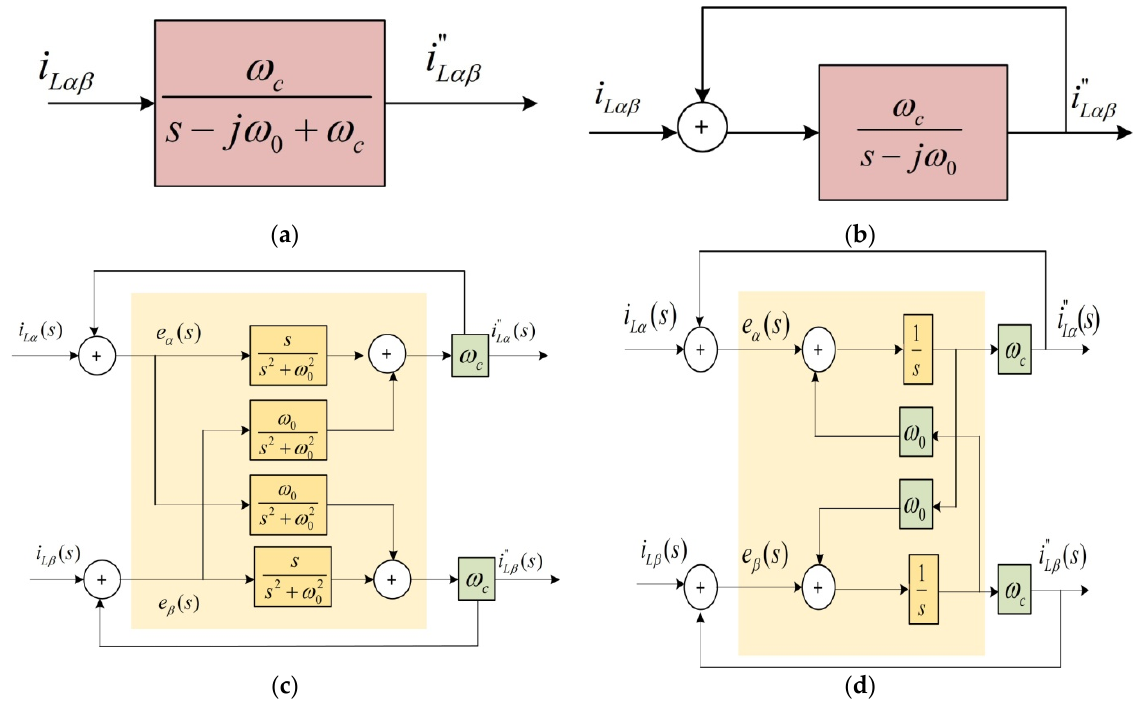
Figure 3. ( a ) Complex vector SFG; ( b ) equivalent complex vector with unity feedback structure; ( c ) scalar implementation of complex-vector-filter; ( d ) simple alternative of complex vector structure. The value of ω c influences the dynamic response and the attenuation of the HFNS components. A higher value of ω c leads to faster dynamic response, but poor HFNS HFNS component, the α -axis and β -axis HFNS components are also extracted in a